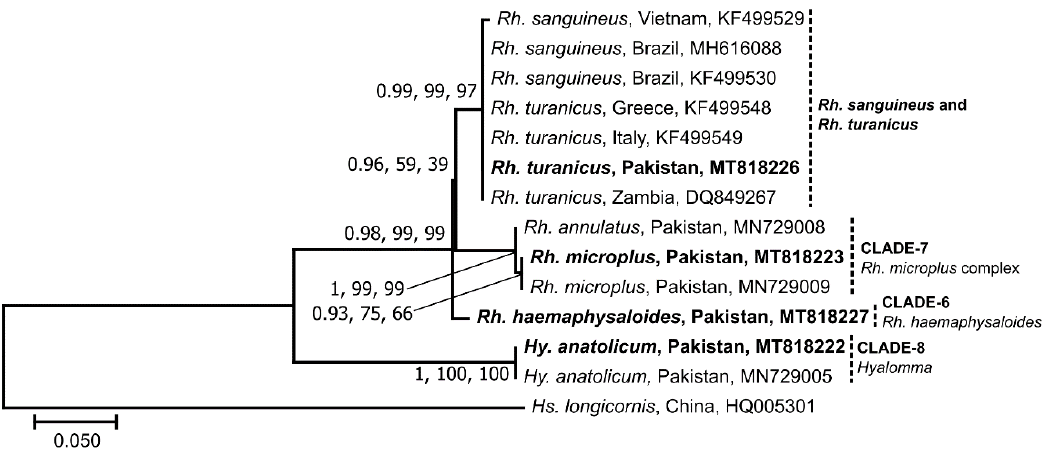
Figure 4. Phylogenetic relationships of partial sequences of the second internal transcribed spacer of the nuclear ribosomal DNA of Rhipicephalus and Hyalomma ticks collected from small ruminants in the FATA of Pakistan. Phylogenies were inferred using Neighbor Joining (NJ, this tree), Maximum Likelihood (ML) and Bayesian Inference (BI) methods. Sequences determined herein are shown in bold. The country of origin and GenBank accession numbers for each sequence are also provided. Nodal support values are presented as a posterior probability for BI (left) followed by bootstrap values for ML and NJ. The scale-bar indicates the number of inferred substitutions per site.